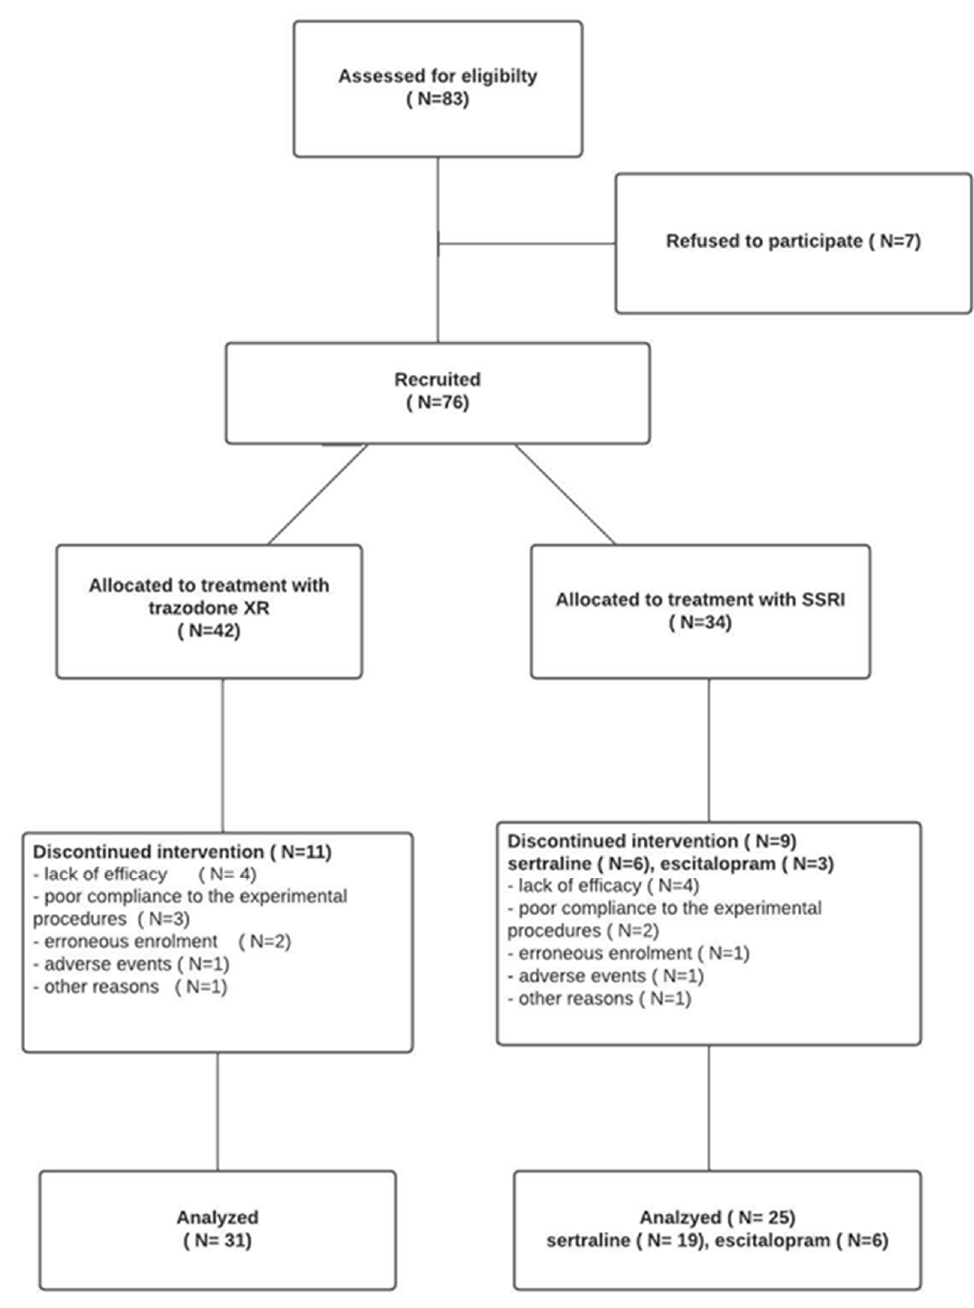
Figure 1. Flowchart of the study. A comparison of the baseline group characteristics is presented in Table 1. There were no significant differences between the treatment groups in age, sex, weight, alcohol consumption, smoking, presence of somatic comorbidities, or psychotherapy use. Patients in the trazodone group had a significantly longer history of psychiatric treatment and higher scores in the QIDS-CR, QIDS-SR, HAMA, AIS, and SDS scales. There were no statistically significant differences between studied groups in the baseline scores of the MADRS and SHAPS